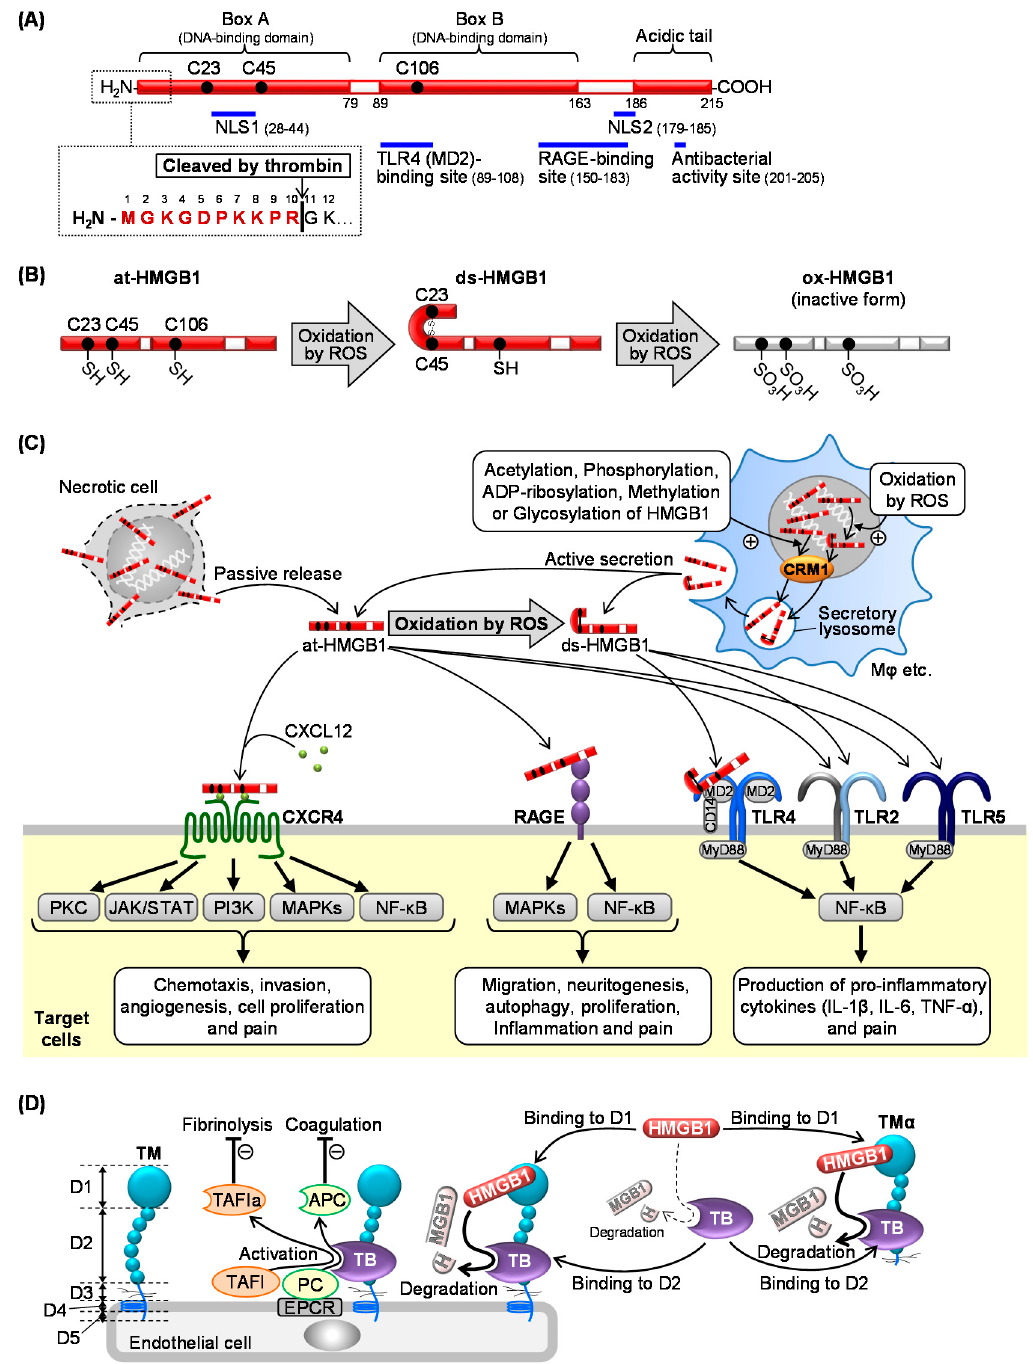
Figure 1. Structure, origins/targets, and inactivation of high mobility group box 1 (HMGB1). ( A ) The structure and thrombin cleavage site of HMGB1. ( B ) Redox-dependent structural conformation of HMGB1. ( C ) Extracellular release and membrane receptors of HMGB1. ( D ) Thrombin-dependent degradation of HMGB1 by thrombomodulin and thrombomodulin alfa. NLS, nuclear-localization signal; at-HMGB1, all-thiol HMGB1; ds-HMGB1, disulfide HMGB1; ox-HMGB1, fully-oxidized HMGB1; ROS, reactive oxygen species; CRM1, chromosome-region maintenance 1; TB, thrombin; ROS, reactive oxygen species; CXCR4, C-X-C motif chemokine receptor 4; CXCL12, C-X-C motif chemokine ligand 12; RAGE, receptor for advance glycosylation end products; TLR, Toll-like receptor; TM, thrombomodulin; TM α , thrombomodulin alfa; TAFI, thrombin-activatable fibrinolysis inhibitor; TAFIa, the activated form of TAFI; PC, protein C; APC, activated protein C; D1, D2, D3, D4, and D5, domain 1, 2, 3, 4, and 5 of thrombomodulin; EPCR, endothelial protein C receptor.